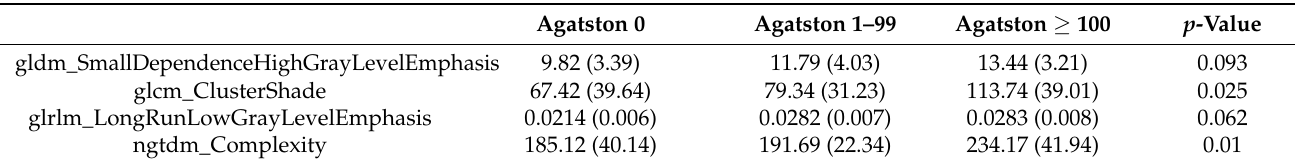
Table 2. Higher-order radiomics features. Mean and (SD) given for continuous variables.